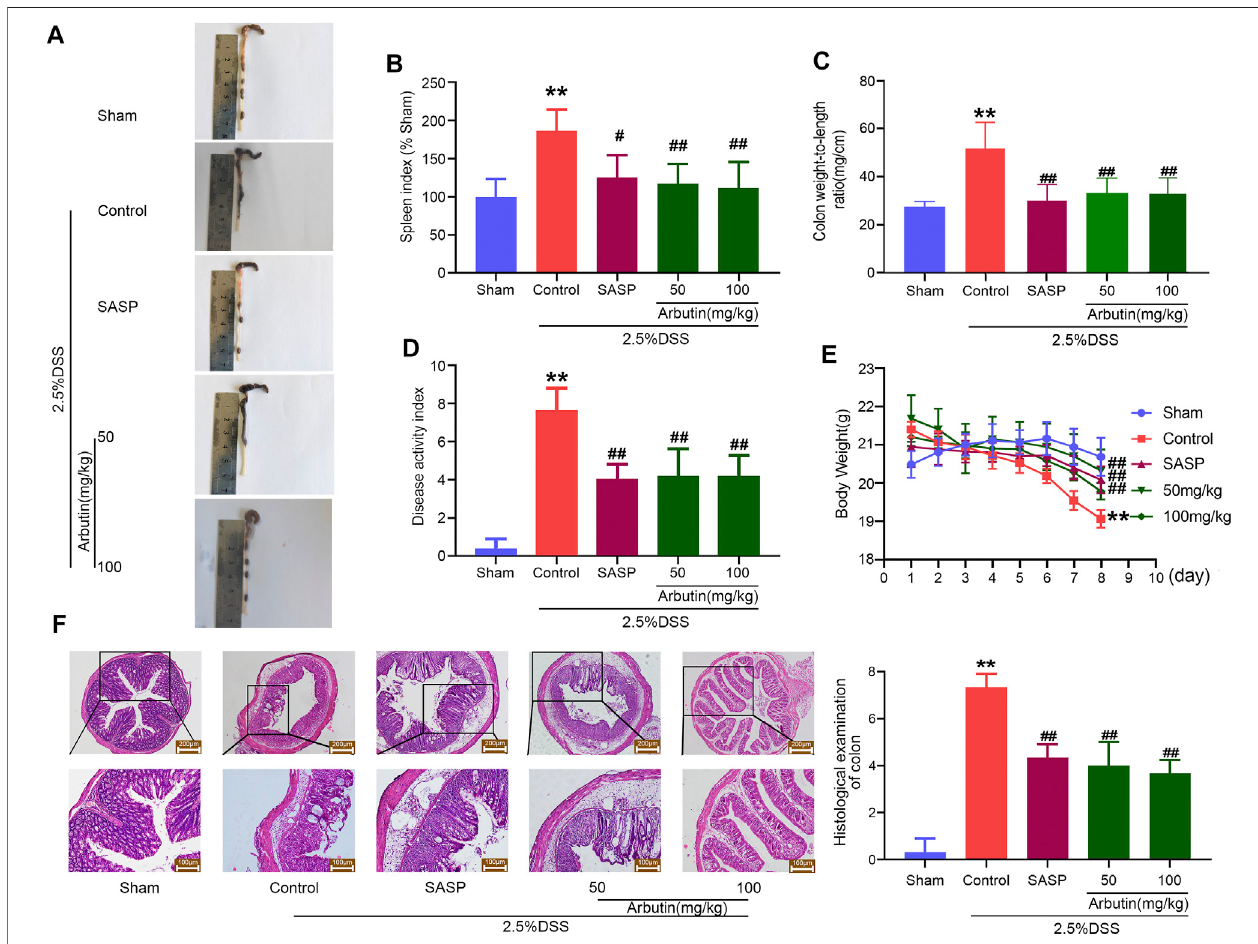
FIGURE 2 | Arbutin alleviates DSS-induced colitis in mice (A) macroscopic observation, (B) spleen index, (C) colon weight-to-length ratio, (D) DAI, and (E) weight loss (F) Representative hematoxylin-eosin-stained colon sections (left panel) and histological score (right panel). Scale: upper panel is 200 μ m, lower panel is 100 μ m. Dataareexpressedasthemean ± SD.** p < 0.01comparedwithshamoperationgroup;# p < 0.05comparedwithDSSinducedcolitisgroup;## p < 0.01comparedwith DSS induced colitis group; n (cid:1) 6 samples.